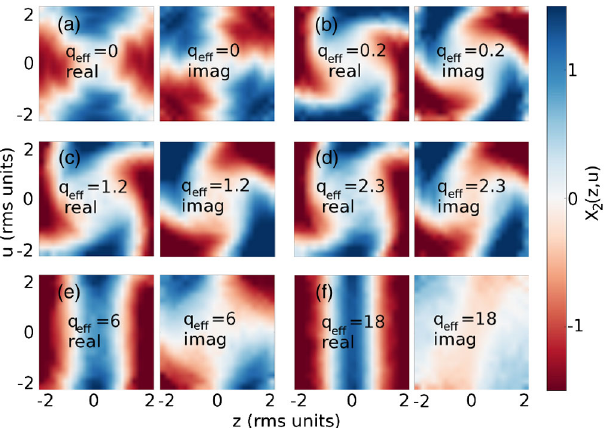
FIG. 3. 3D-G bunch. (a) – (f) The mode 2 longitudinal distri- bution, X 2 ð z; u Þ , for different values of the space charge param- eter q . Without space charge, X 2 ð z; u Þ ∝ e i 2 θ . With increasing eff q , X 2 ð z; u Þ transforms gradually to the second space charge eff harmonic [see Fig. 1(b)]. At large q by a purely real function.